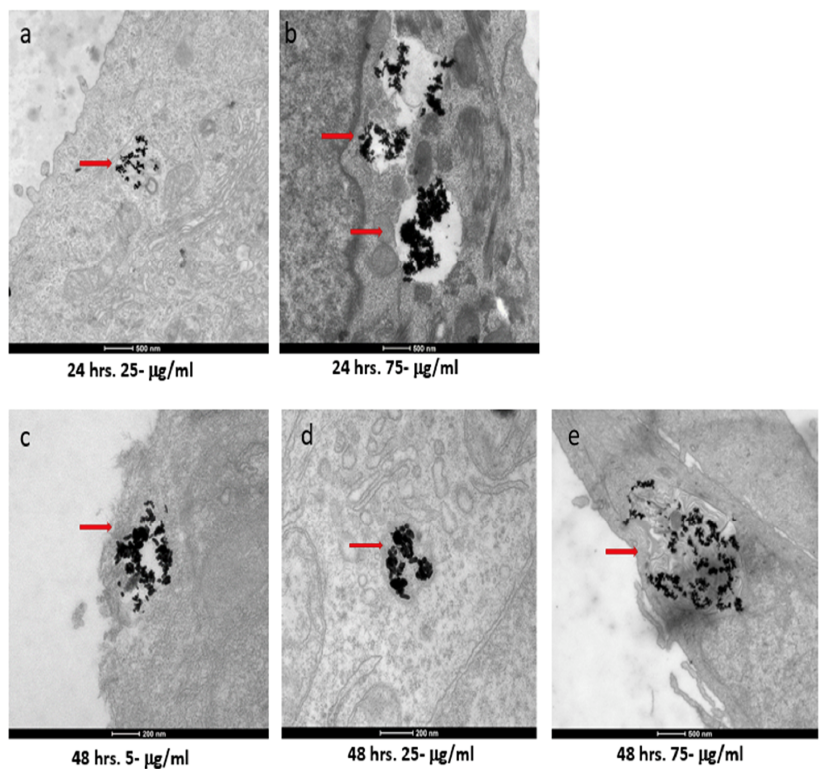
Figure 5. TEM images of AuNRs in MCF-7 cells at different time points and concentrations. MCF-7 cells were treated with 5, 25, and 75 µ g/mL of AuNRs for 1, 4, 24, and 48 h. Internalization of nanorods was observed starting at 24 h with 25 and 75 µ g/mL concentrations (( a ) and ( b ), respectively). For cells incubated for 48 h, we observed internalization with 5, 25, and 75 µ g/mL concentrations (( c ), ( d ), and ( e ), respectively). Red arrows point to gold nanorods localized in MCF-7 cells. Electron photomicrographs shown are representative of at least three independent experiments with similar conditions.